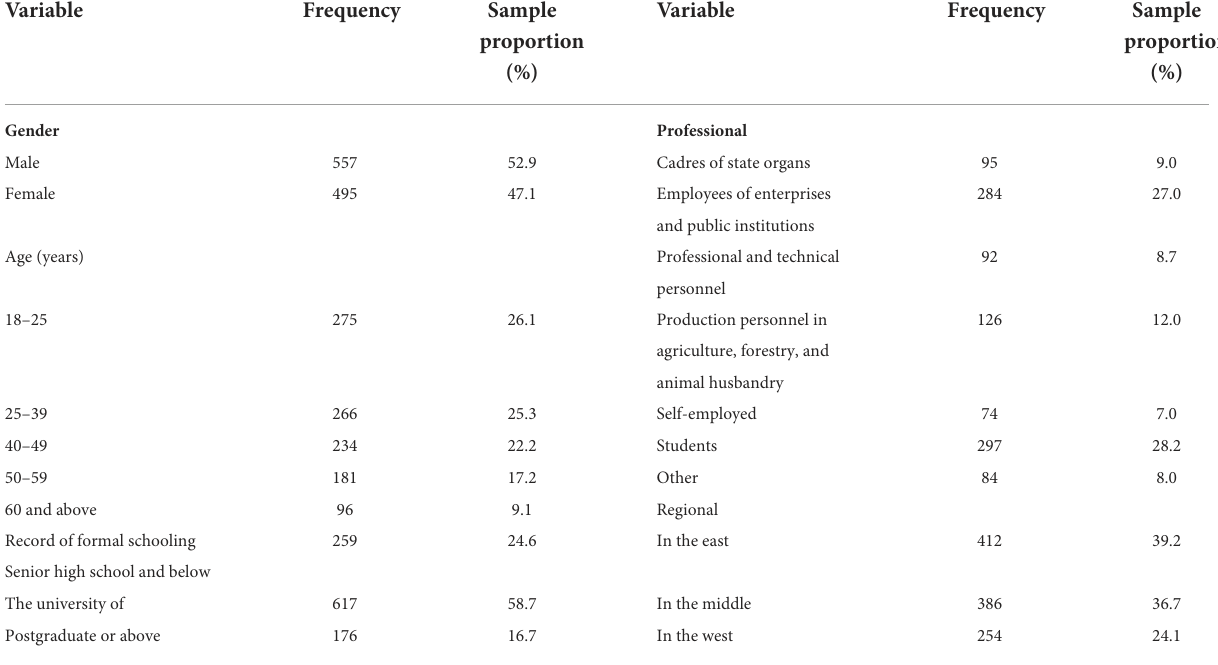
TABLE 1 List of demographic characteristics of subjects ( n = 1,052).